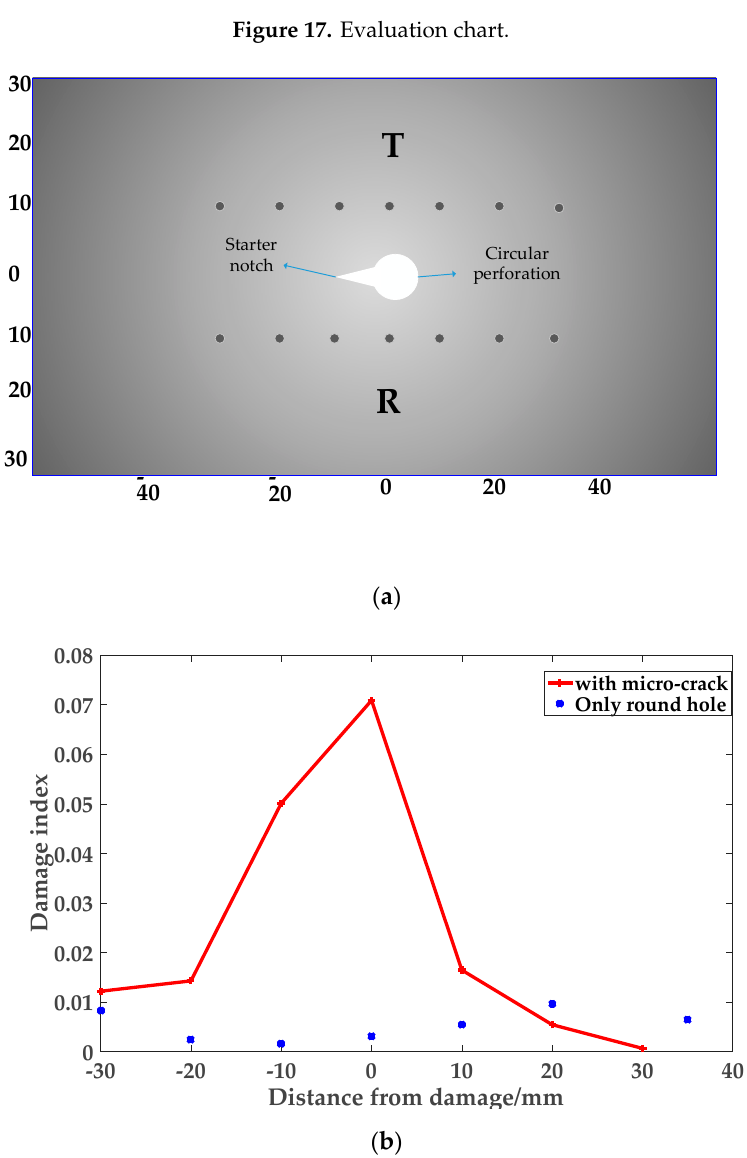
Figure 18. β in the sheet material without microcrack: ( a ) The probe layout without crack; ( b ) Figure18. β inthesheetmaterialwithoutmicrocrack: ( a )Theprobelayoutwithoutcrack; ( b )distribution distribution pattern of β . pattern of β